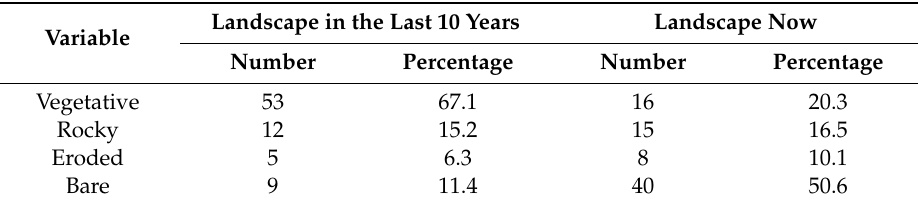
Table 2. Landscape as described by the population living close to the quarry sites ( n = 79).